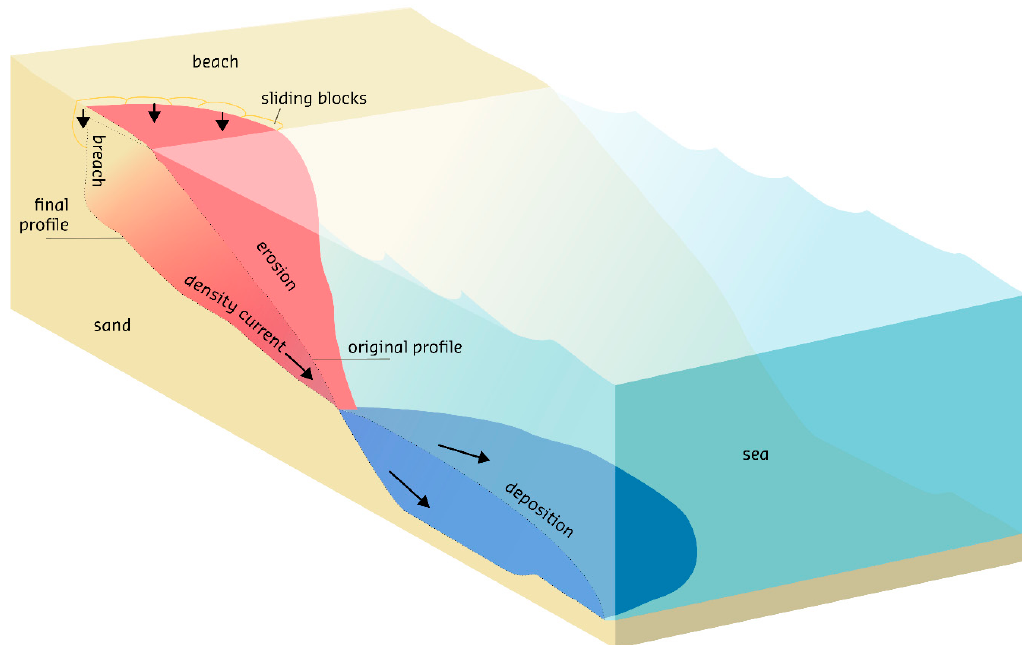
Figure 15. Schematic diagram of a flow slide or RBF event in the coastal shoreface retrogressing into the foreshore and beach during low water (Left: Cross section. Right: 3D view. Red = erosion, blue = deposition). Graphics: R. Savert.